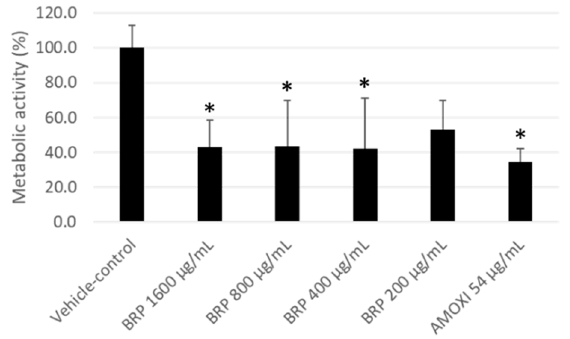
Figure 1. Metabolic activity of multispecies biofilm cultures treated with the dilution vehicle (negative control), Brazilian Red Propolis (BRP) ethanolic extract (1600, 800, 400 and 200 µg/mL) and amoxicillin (AMOXI) (54 µg/mL). Vehicle-treated biofilms were considered as with 100% metabolic activity. (*) indicates significant differences when compared to the control group (Kruskal–Wallis followed by Dunn’s post-hoc test, p ≤ 0.05).